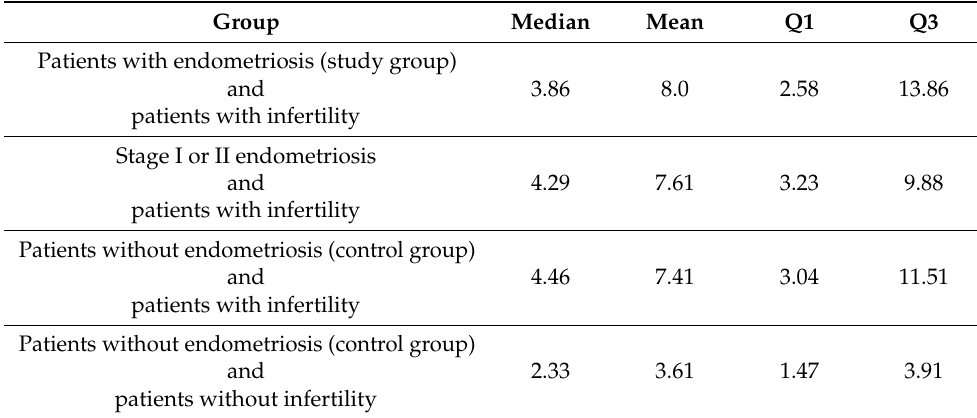
Table 5. Characteristics of CDH 12 concentrations (ng/mL) within different groups (including patients with infertility).